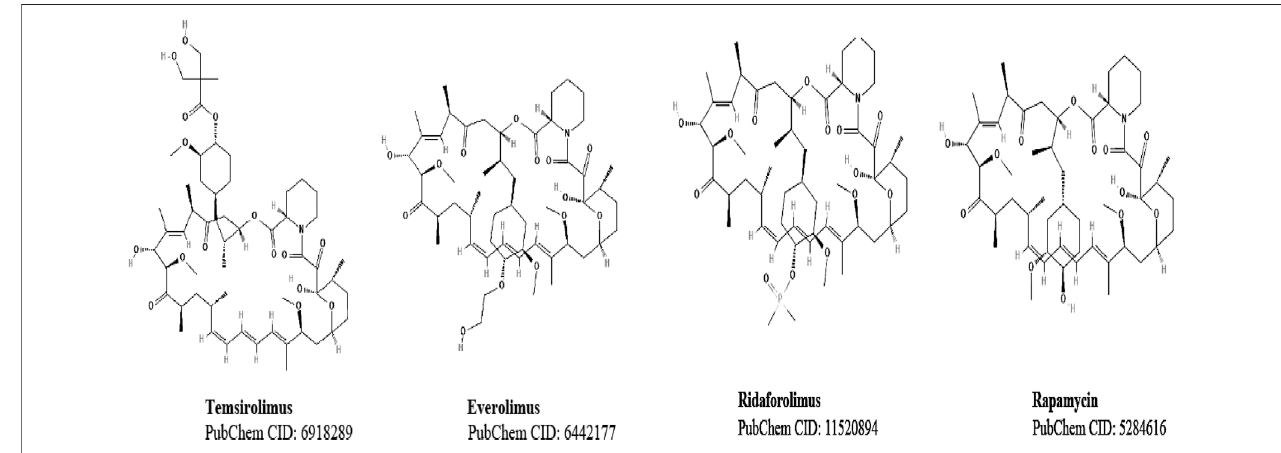
FIGURE 1 | Structure of temsirolimus and its